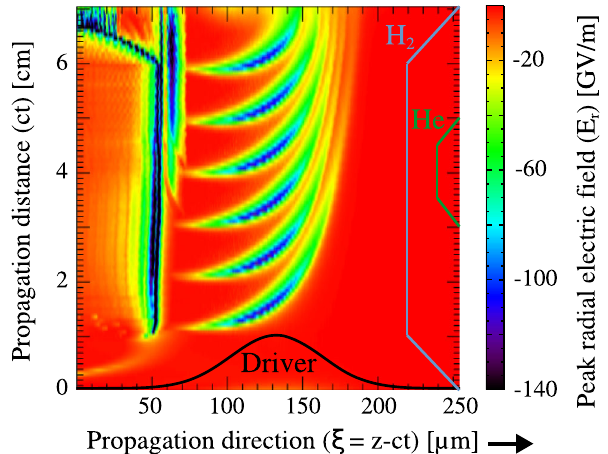
FIG. 1. Color map of the simulation peak radial electric field, E ξ ¼ z − ct and propagation r , along the co-moving direction distance, ct . Color bar reaches up to − 150 GV = m. Blue and green lines illustrate the plasma and He impurity longitudinal density profiles, of the control simulation. Black line shows the driver profile normalized to background plasma density, n 0 . The driver propagates from left to right side of the